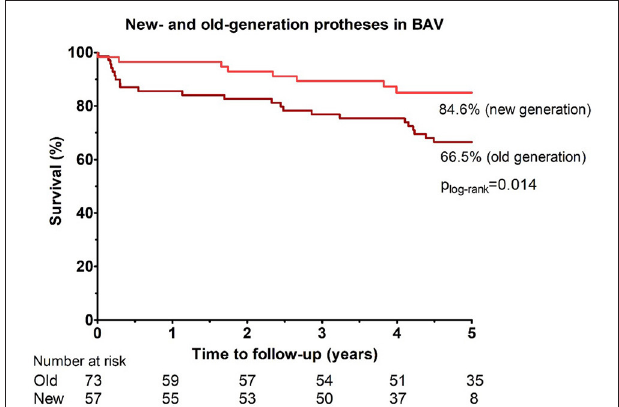
FIGURE 4 | Cumulative incidences of all-cause mortality up to 5 years of follow-up among patients with bicuspid aortic valve who received new-generation vs. old-generation